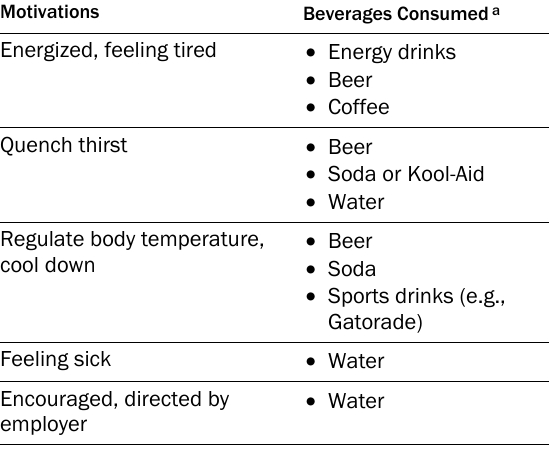
Table 5. Motivations and Choices for